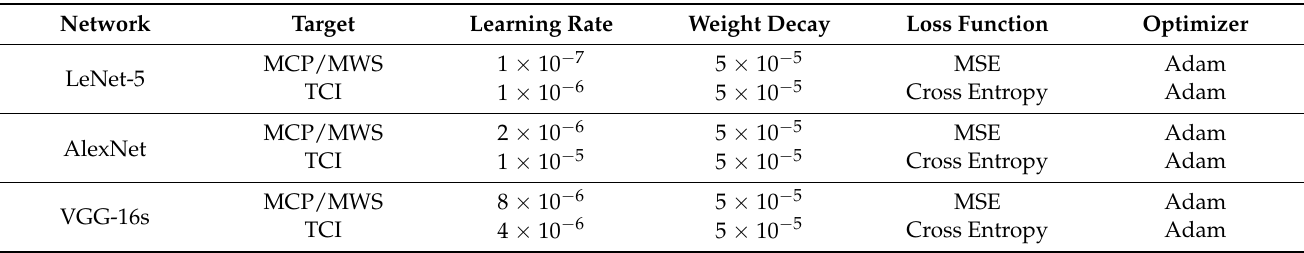
Table 2. Experimental